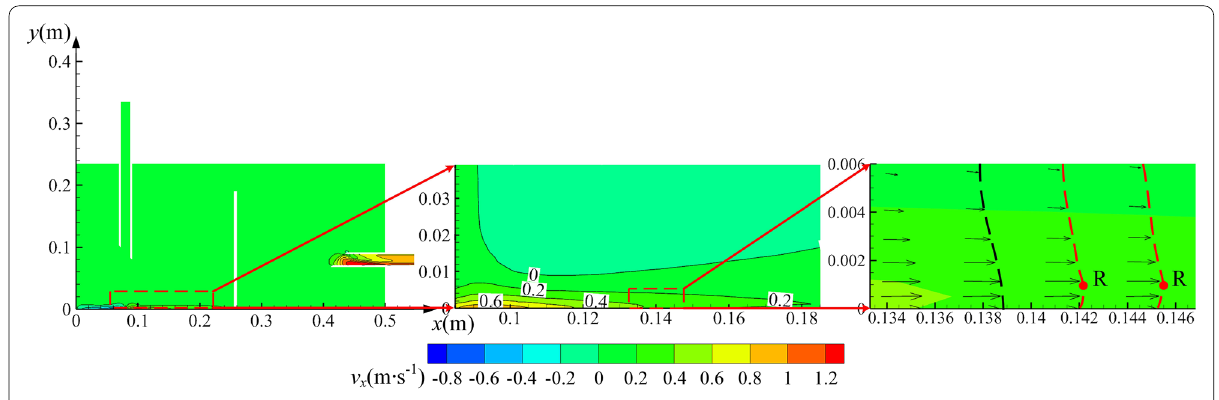
Figure 11 X -velocity contour and vector diagram of the middle surface in the model